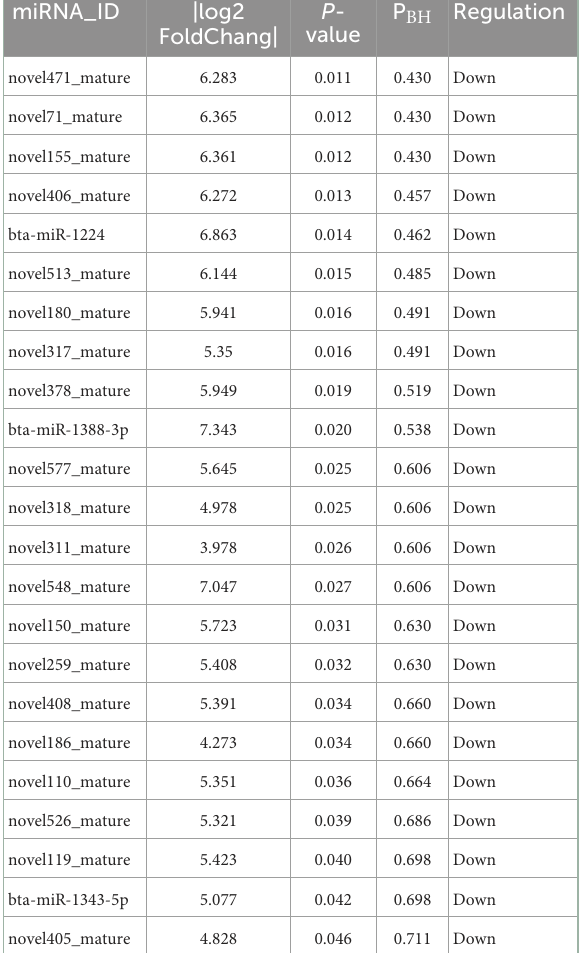
TABLE 2 Significantly differentially expressed miRNAs in intrauterine exosomes between the donor and recipient cows on 7 days after fertilization (donor group vs. recipient